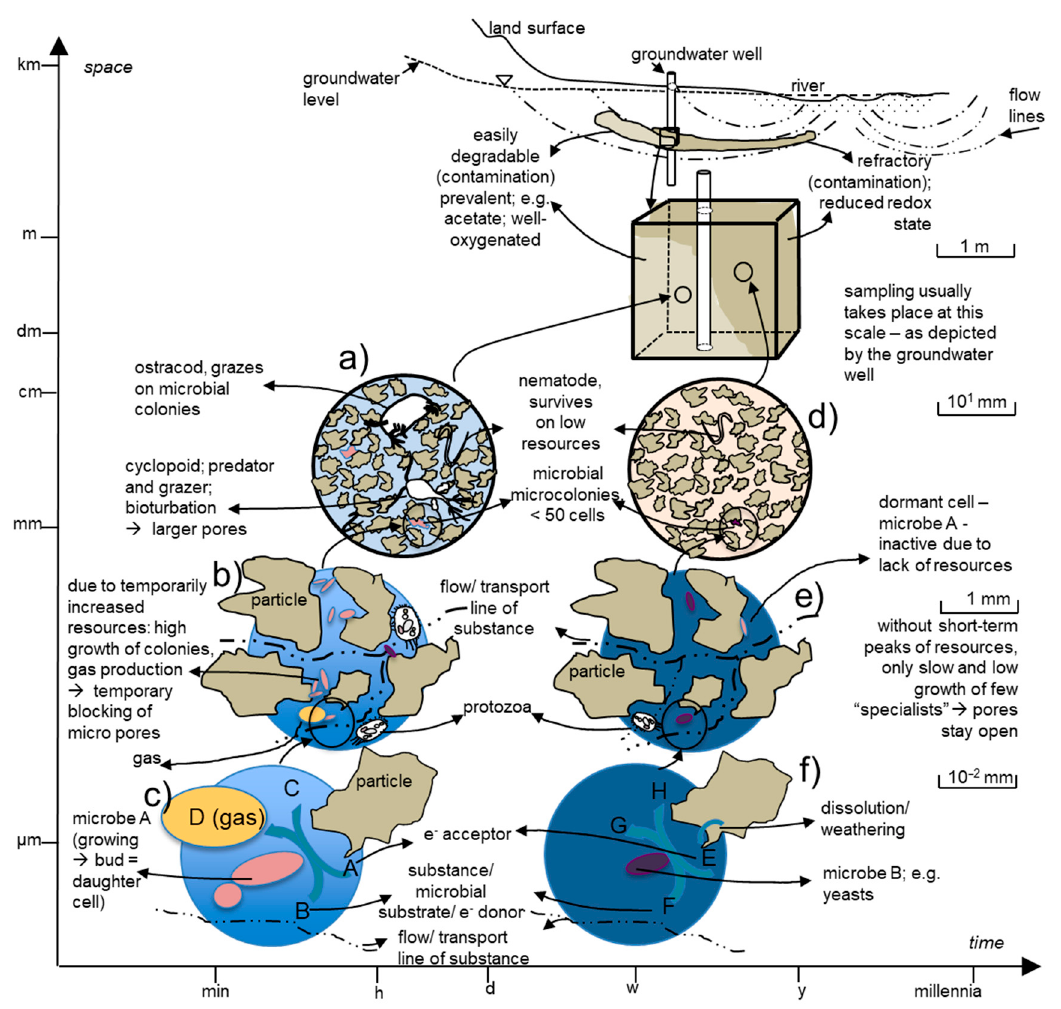
Figure 1. Pore scale conditions at the micrometer, millimeter, and decimeter extents. Two depictions of areas are shown. It is possible that they are separated temporally or spatially, as shown. These two situations might also occur in sequence at the same spot. X axis: time; y axis: space. Adapted from Schmidt et al. [11].